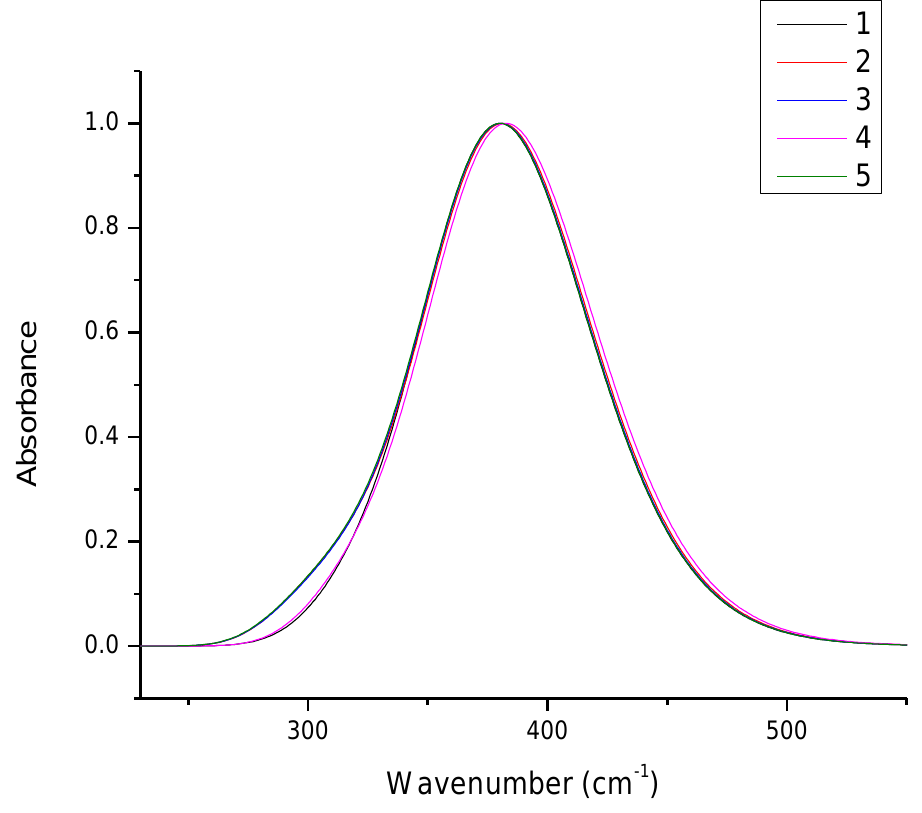
Figure 6. UV-visible spectra of 1 to 5 .